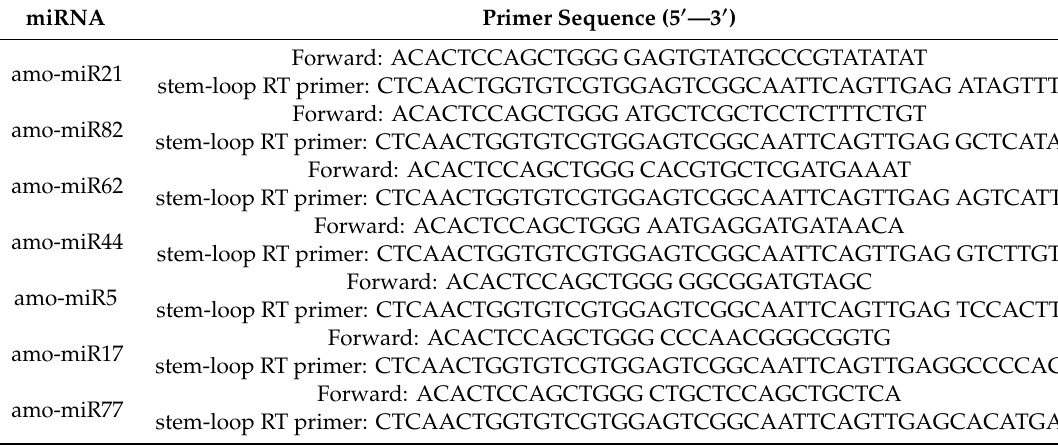
Table 1. Primer sequences for qRT-PCR.